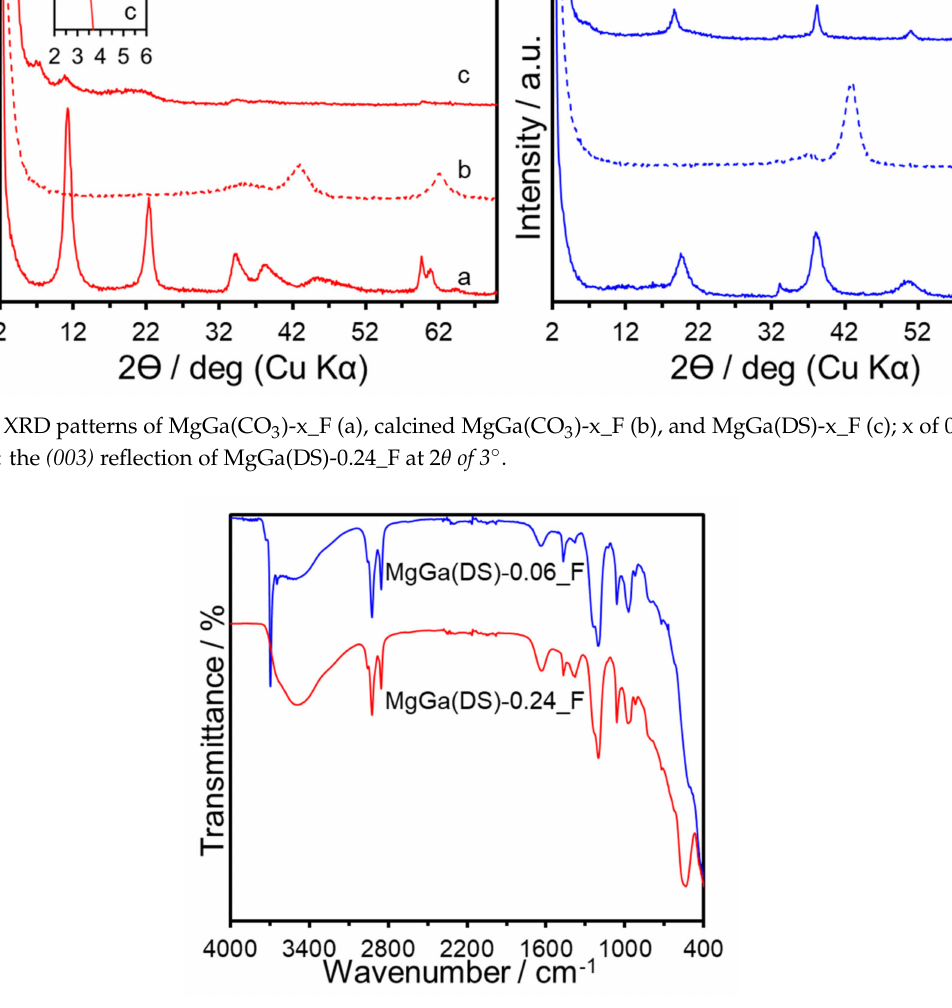
Figure 9. IR spectra of MgGa(DS)-0.24_F and MgGa(DS)-0.06_F. The effect of x value on the dispersion was examined using MgGa(CO 3 )-x_F (x = 0.24 and 0.06) to be dispersed in water. Figure 10A,B shows the photograph of the dispersion before and after the storage for 6 h without agitation. MgGa(CO 3 )-0.24_F sedimented while MgGa(CO 3 )-0.06_F was dispersed. The dispersion of MgGa(DS)-x_F (x = 0.24 and 0.06) in hexanol was also examined and the appearance of the dispersion are shown in Figure 10C,D. MgGa(DS)-0.06_F was dispersed in hexanol, while MgGa(DS)-0.24_F sedimented. Since particles sizes were not different significantly for the samples, the difference in the dispersion behavior was thought to be a result of the difference in the layer charge